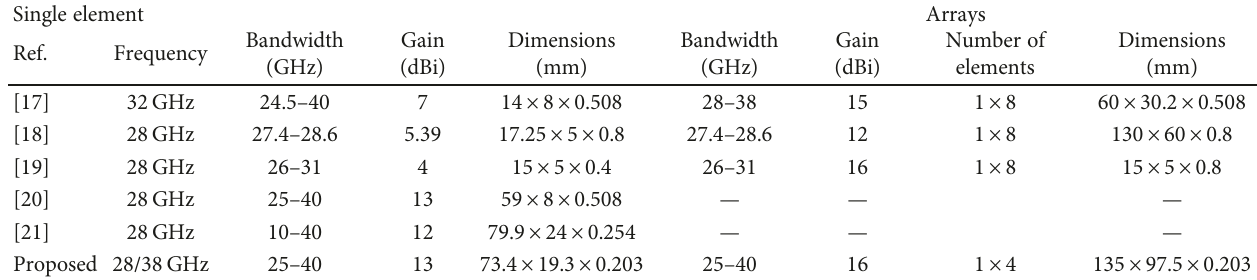
Table 1: Characteristic comparison of various Vivaldi antenna designs.